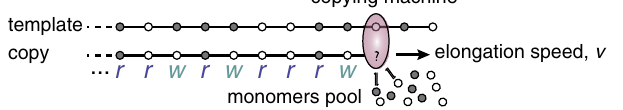
FIG. 1. Template-assisted polymerization. The template strand is a preexisting polymer made up of two different kinds of monomers (gray and white circles). A molecular copying machine (red circle) assists the growth of a copy strand by incorporating freely diffusing monomers of two different types, trying to match them with those of the template strand. Right and wrong matches are noted r and w .